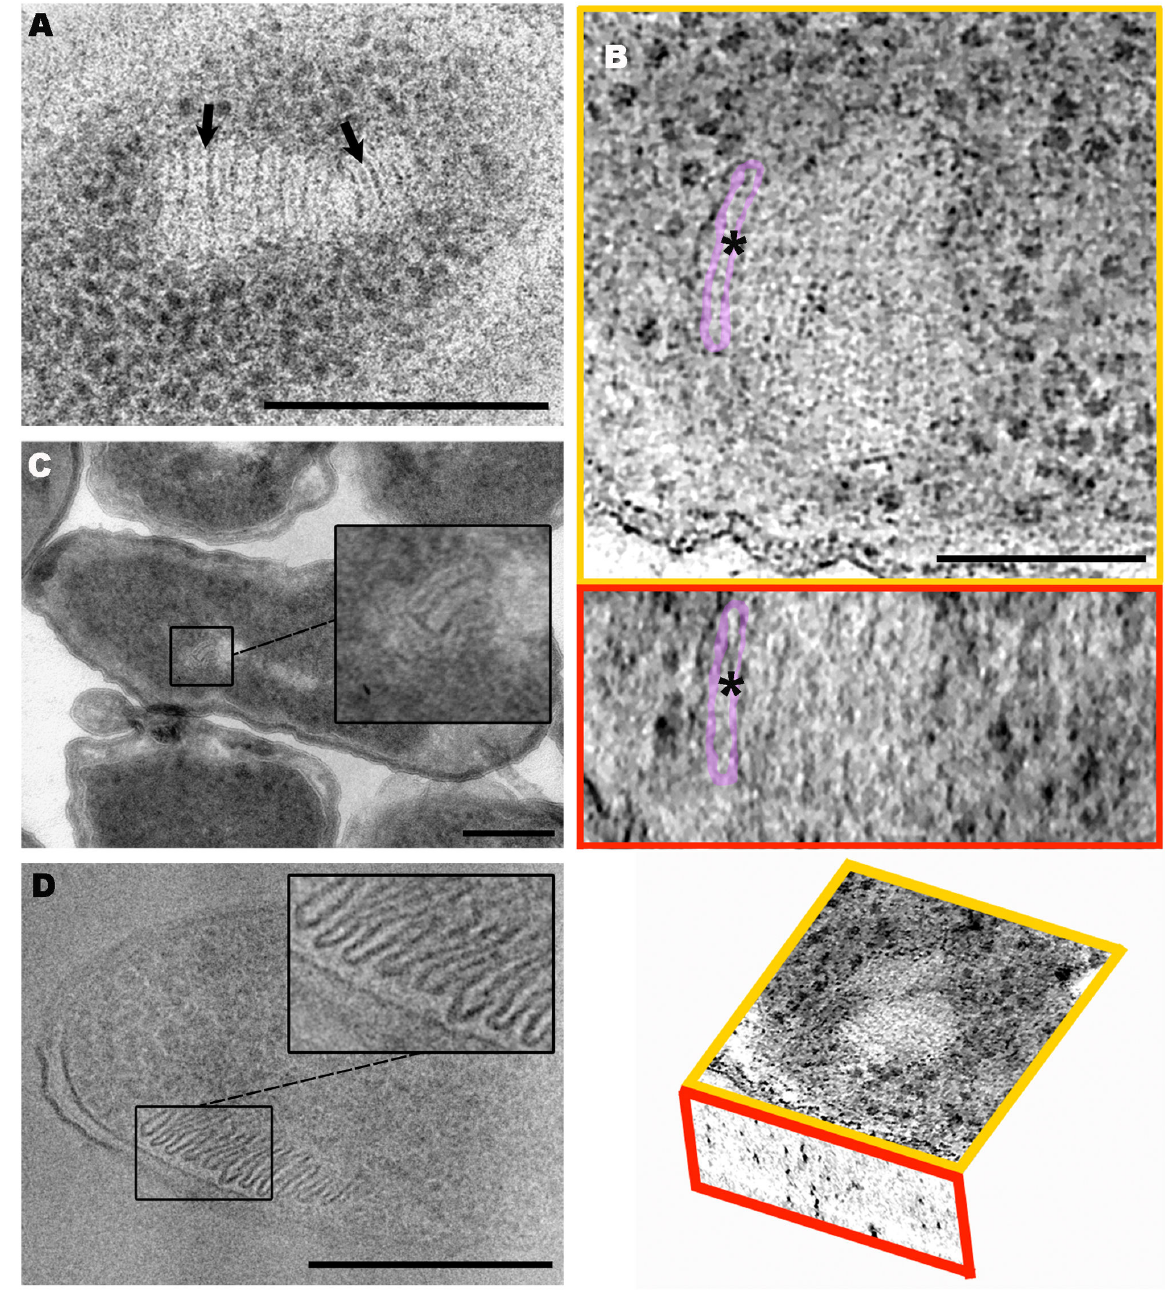
Figure 4. TEM and Cryo-TEM analysis of stacks of P. deceptionensis M1 T . (A) A 60 nm Epon section from a sample processed by HPF-FS. A stack is visualized composed by clustered discs transversally cut, each of which is delimited by a membrane-like structure (black arrows). Scale bar = 250 nm. (B) 1.5 nm tomogram slices from the XYZ views of a bflow-filtered tomogram reconstructed from 250 nm Lowicryl HM23 sections. The asterisks correspond to the same point through the different views. The XY (top image) and the XZ (middle image) views show flat clustered discs transversally cut and perpendicularly distributed to the PM in a fragment of a cell. A membrane-like structure is observed surrounding each flat disc, one of which has been colored in both views. The bottom picture is a scheme of the view’s distribution in the tomogram. Scale bar = 100 nm. (C) A 60 nm Tokuyasu section. Stacked discs are also observed well delimited by a membrane-like structure (see magnified squared area). Scale bar = 250 nm. (D) A 50 nm vitreous cryosection micrograph (CEMOVIS). Clustered discs are observed clearly delimited by a membrane (see squared area). Scale bar = 250 nm. doi: 10.1371/journal.pone.0073297.g004 PLOS ONE |